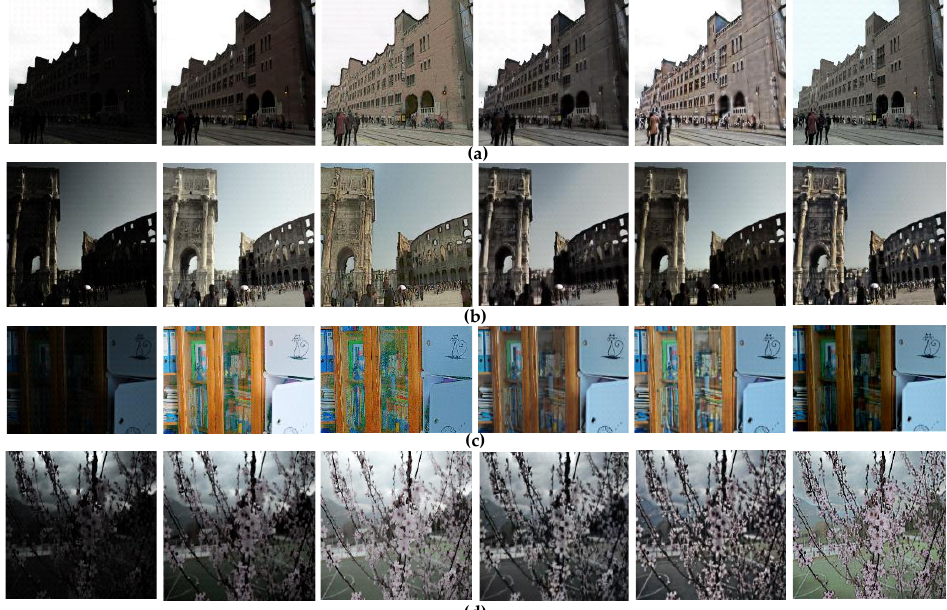
Figure 6. Low-illumination MSRCR RetinexNet KinD MBLLEN Ours. Comparison of the processing effects on the general dataset. the leftmost column is the low-illumination image, and the other four columns are the results of the low-illumination image processed by MSRCR, RetinexNet, KinD, MBLLEN and our proposed algorithms.